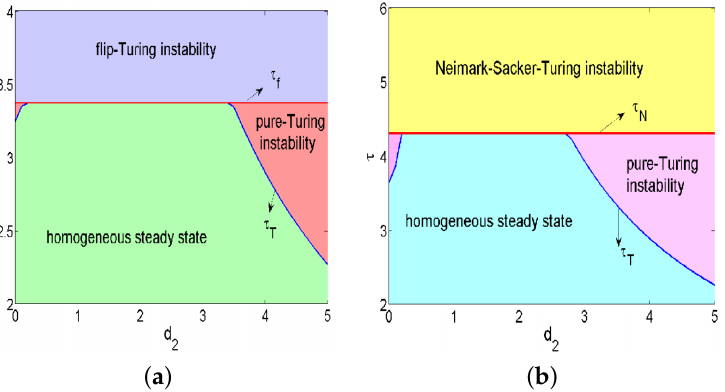
Figure 5. ( a ) Z m − τ diagram for Turing instability in flip bifurcation; ( b ) Z m − τ diagram for Turing instability in Neimark–Sacker bifurcation.